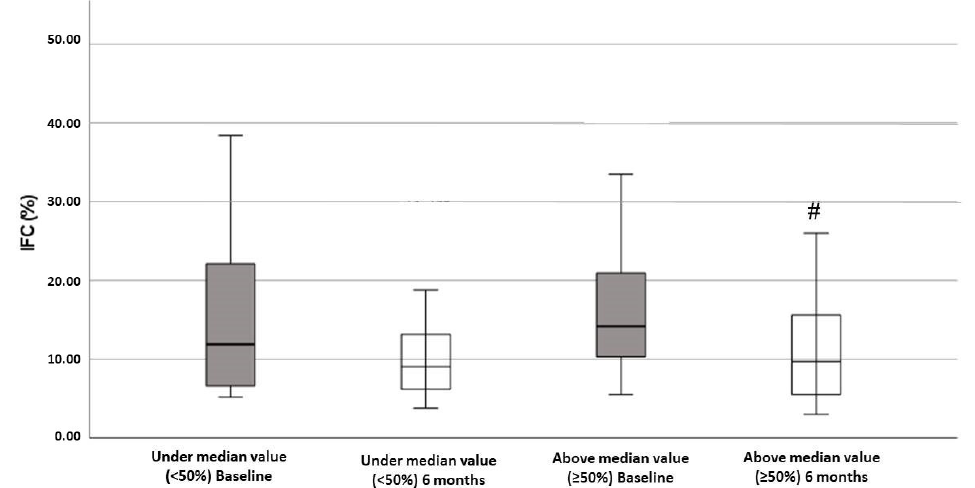
Figure 1. Intrahepatic fat contents (IFC) of patients in this study, classified according to adherence to Mediterranean diet (AMD). Significant improvement of IFC was found after 6 months of follow- up in above median value group ( ≥ 50%). Statistics: Two-way ANOVA. Results are presented as mean ± SEM. # Difference in means between time.